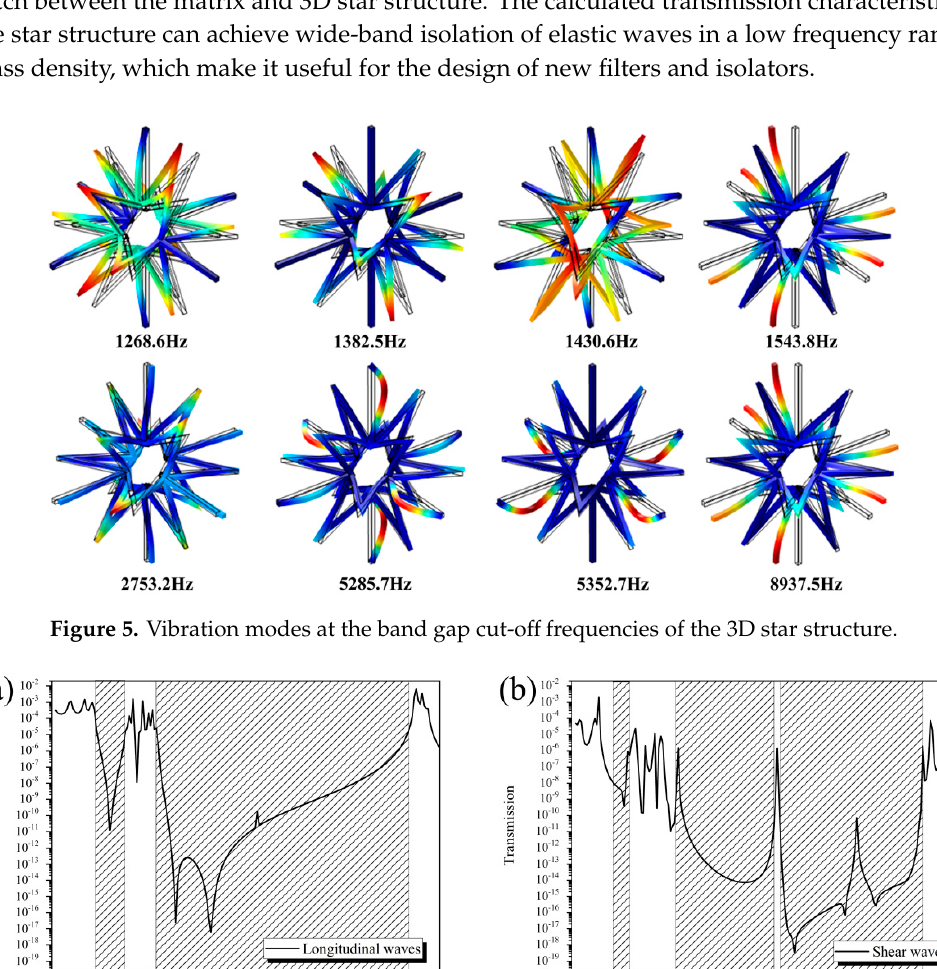
Figure 5. Vibration modes at the band gap cut-off frequencies of the 3D star structure.